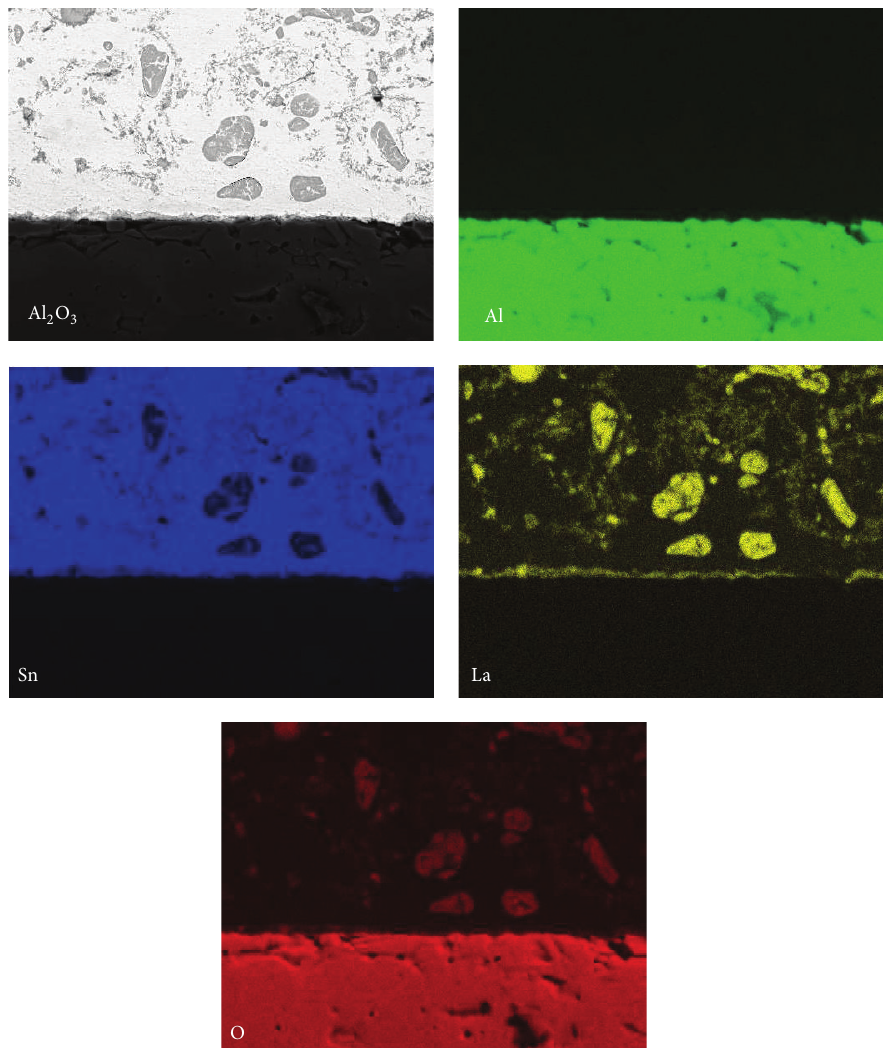
Figure 18: Planar EDX analysis of soldered Sn2La/Al 2 O 3 boundary.